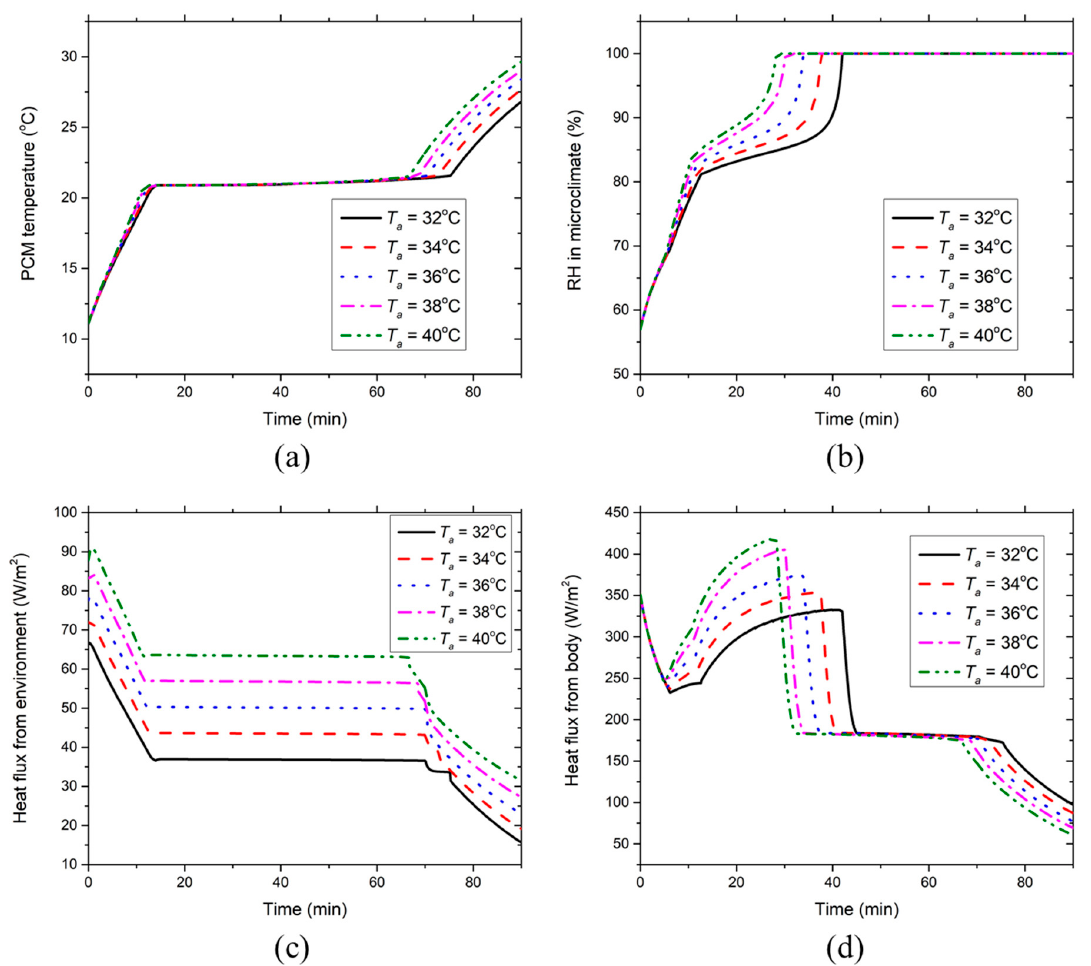
Figure 4. Effect of environmental temperature on the time course of ( a ) PCM temperature, ( b ) clothing microclimate RH, ( c ) PCM heat absorption from the environment and ( d ) PCM heat absorption from the body at the chest segment covered with PCMs and insulation pads at RH = 50%.